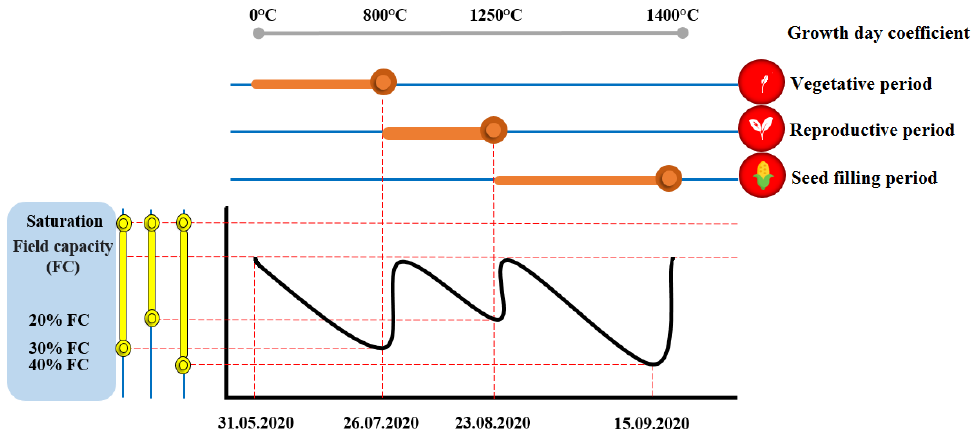
Figure 7. Time monitoring of decision data over time (GDD in three growth periods).